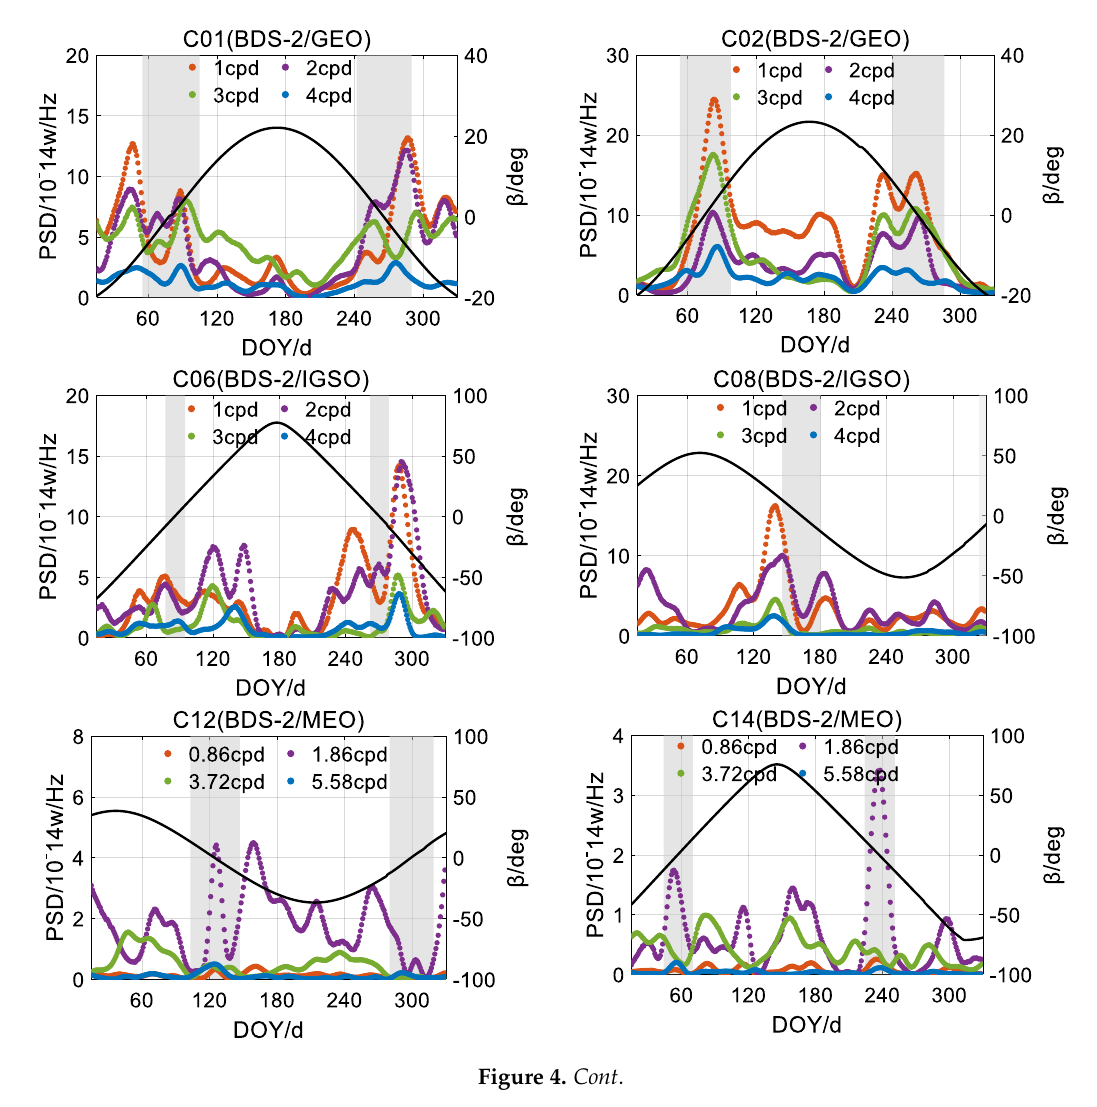
are extracted and analyzed. The results of BDS-2 GEO satellites C01 and C02, BDS-2 IGSO satellites C06 and C08, BDS-2 MEO satellites C12 and C14, BDS-3 MEO satellites C19 and C21 made by CAST and BDS-3 MEO satellites C25 and C27 made by SECM are shown in Figure 4. The vertical axis on the left represents the PSD of periodic terms, and the vertical axis on the right represents the β angle. When the absolute value of β angle is less than a critical value, the satellite enters the eclipse seasons [44]. For GEO and IGSO satellites, the value is 8.5 deg, while for MEO satellites the value is 14.5 deg [45,46]. The shaded regions in Figure 4 represent the eclipse